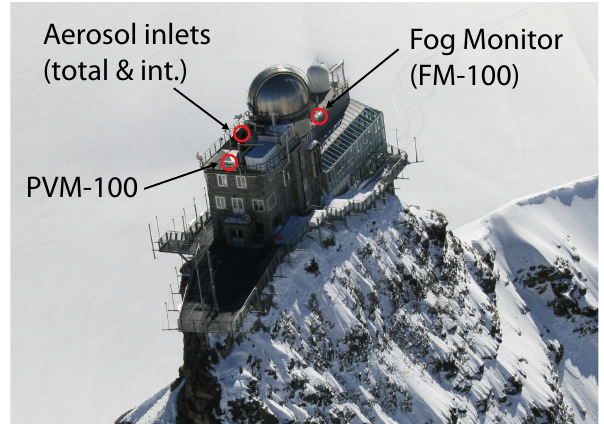
Fig. 1. Position of the Fog monitor (FM-100), Particulate Volume Monitor (PVM-100) and aerosol inlets at the Sphinx platform at the Jungfraujoch (3580ma.s.l.) during CLACE 2010 (photo courtesy of Boris Schneider, www.metair.ch).